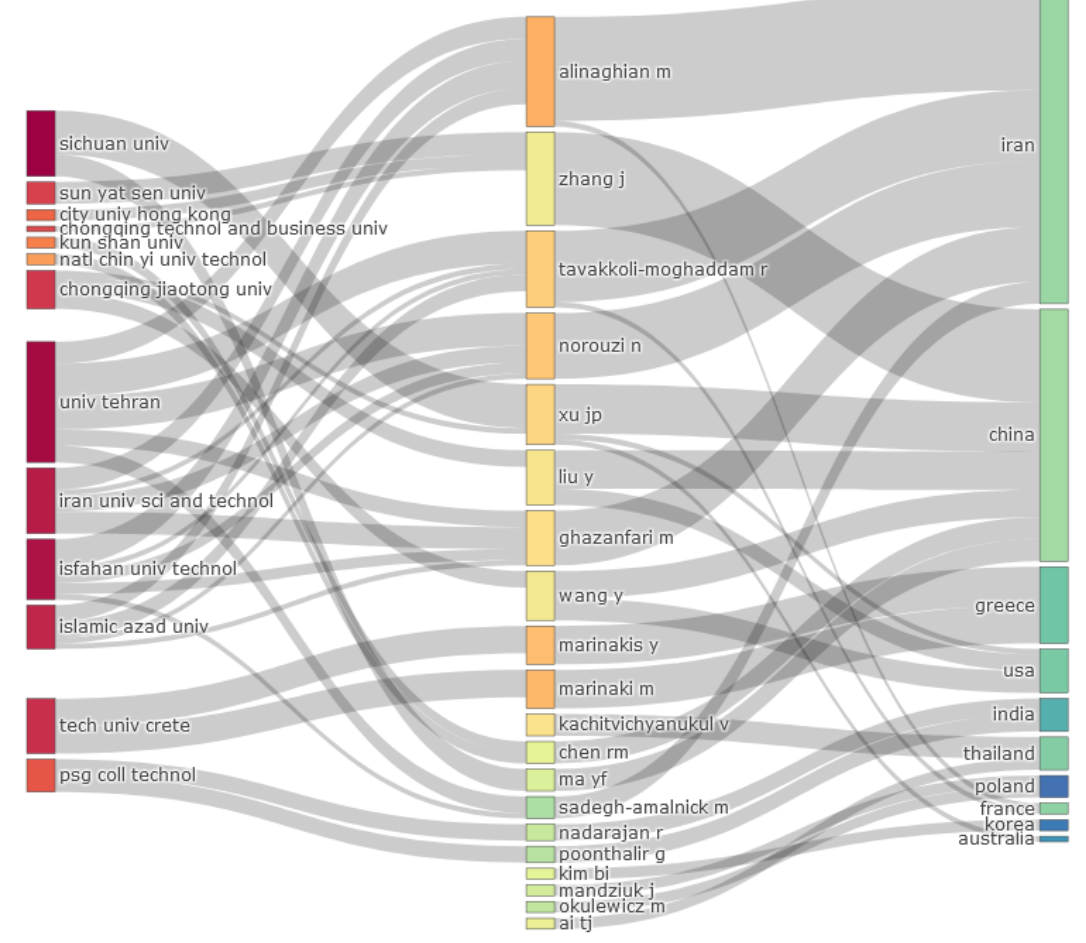
Figure 6. Three-field plot (institutions, authors, countries) for PSO/VRP research, scaled to Web of Science publication counts.